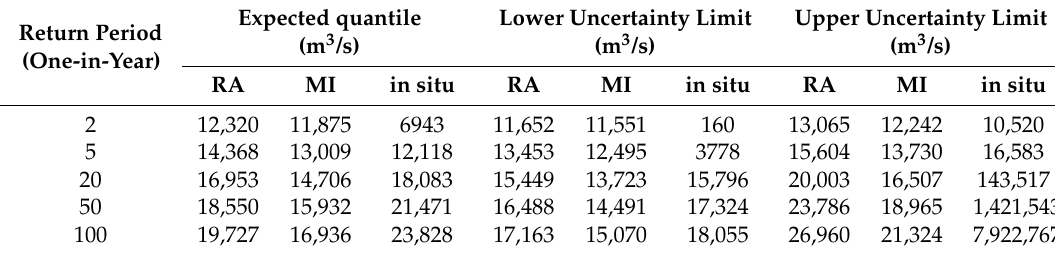
Table 7. Umaisha flood quantile estimates and uncertainty boundaries for in situ, MI and RA filled datasets.